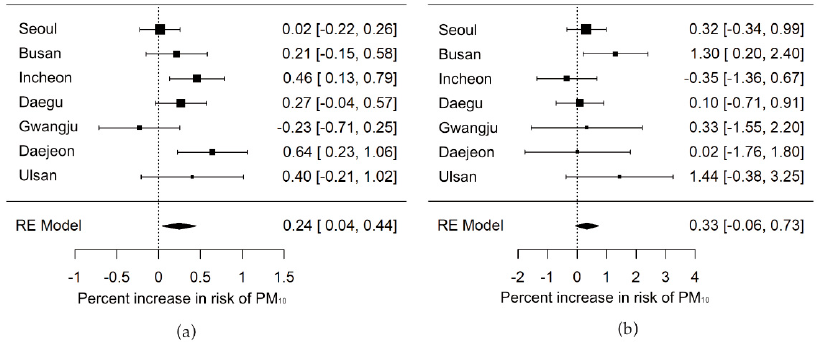
Figure 2. City-specific and pooled effect estimates of PM 10 for stroke outpatients in the seven major cities of Korea, 2002–2015. ( a ) Hospital outpatients for ischemic stroke; ( b ) hospital outpatients for hemorrhagic stroke; RE model: Random effect model.